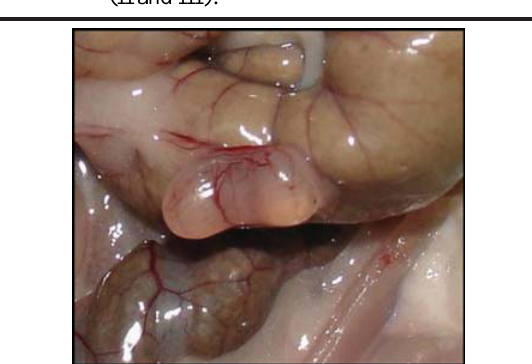
FIGURE 4 - Photomicrography showing self-transplantation mostly found in our study, degree III in the implantation classification system for growth degree according to Quereda et al 5 , with diameter above 4,5mm.